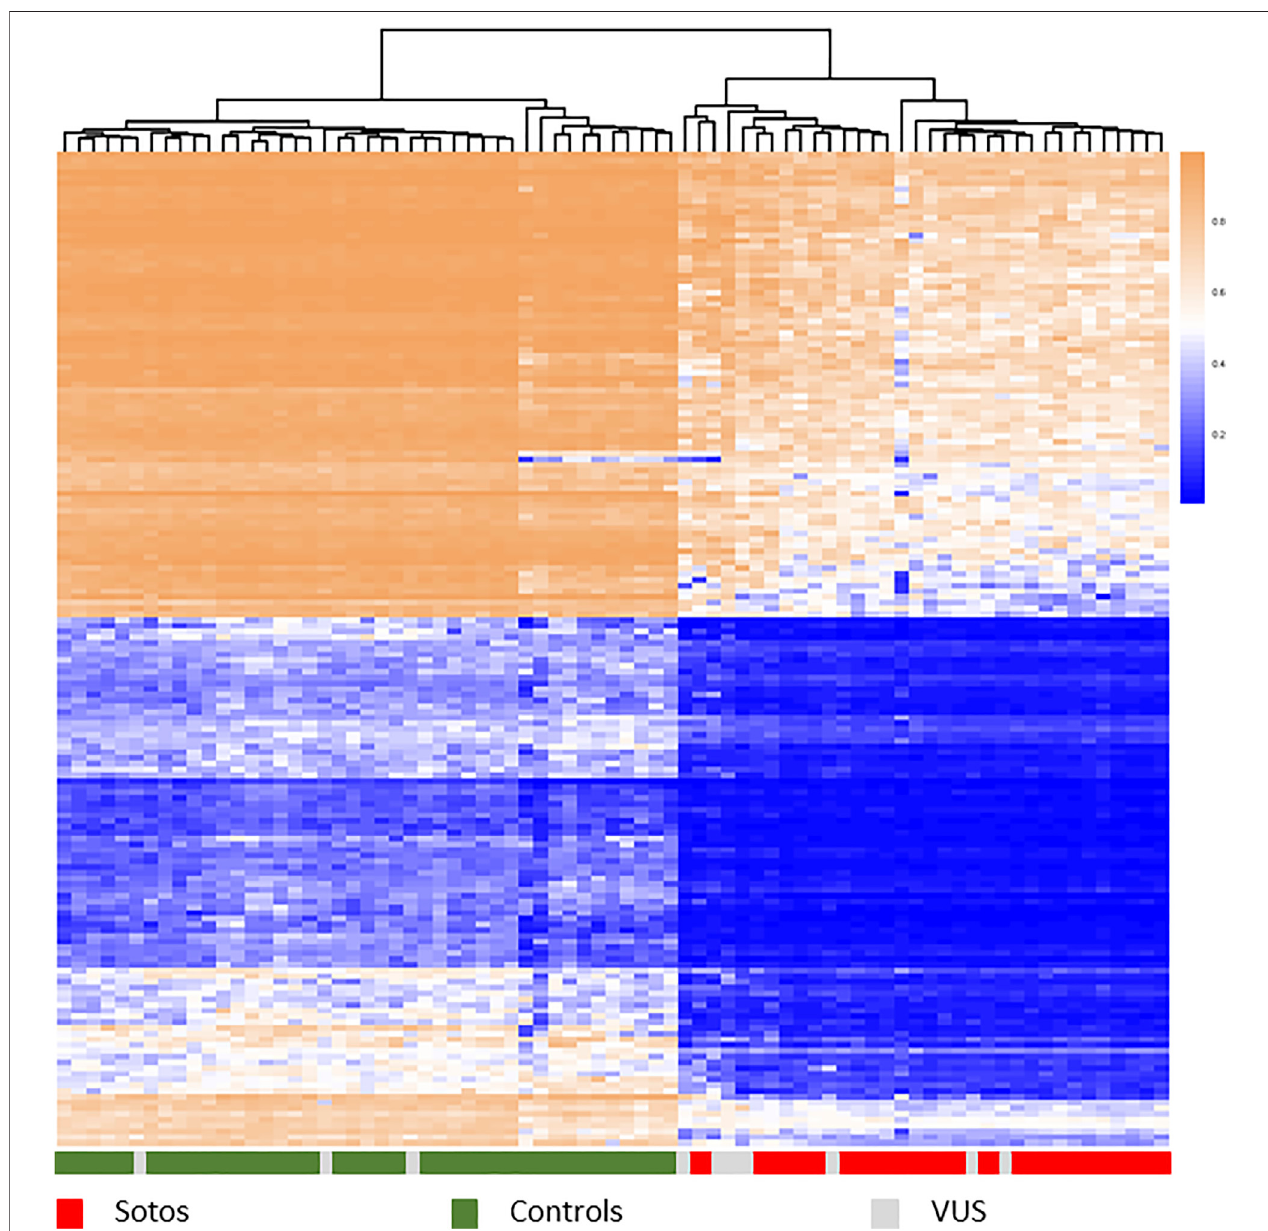
FIGURE 1 | Hierarchical clustering heatmap showing different methylation pro fi les between Sotos syndrome patients (red) and control samples (green) using the top 1,000 most differentially methylated probes between these two groups. Methylation shown from 0 to 1. Patients carrying different types of a variant of unknown signi fi cance (grey) map either with controls or with cases, con fi rming the diagnosis Sotos syndrome in those clustered within the true cases. Samples: publicly available data set GSE74432 (62 samples, Choufani et al., 2015) and an Amsterdam UMC cohort of 15 samples.